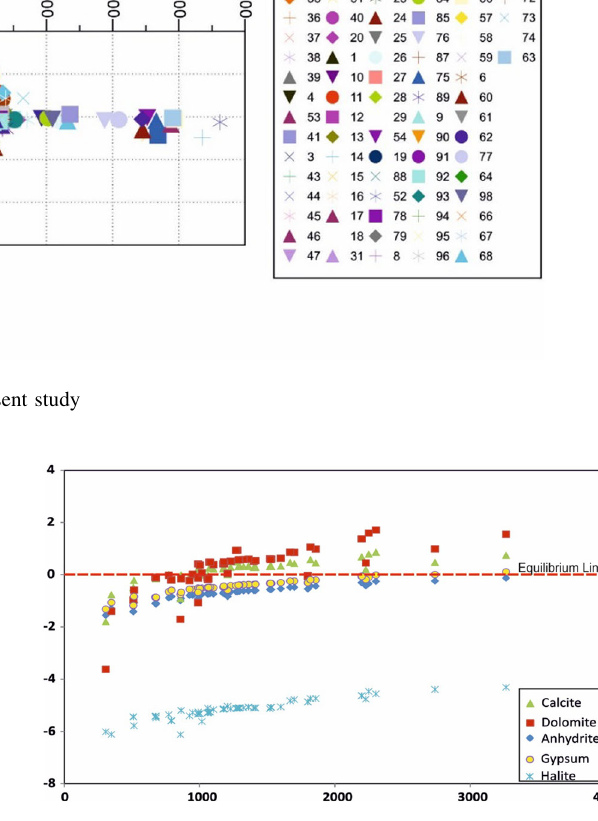
Fig. 10 Plot of saturation indices with respect to carbonate and evaporate minerals against